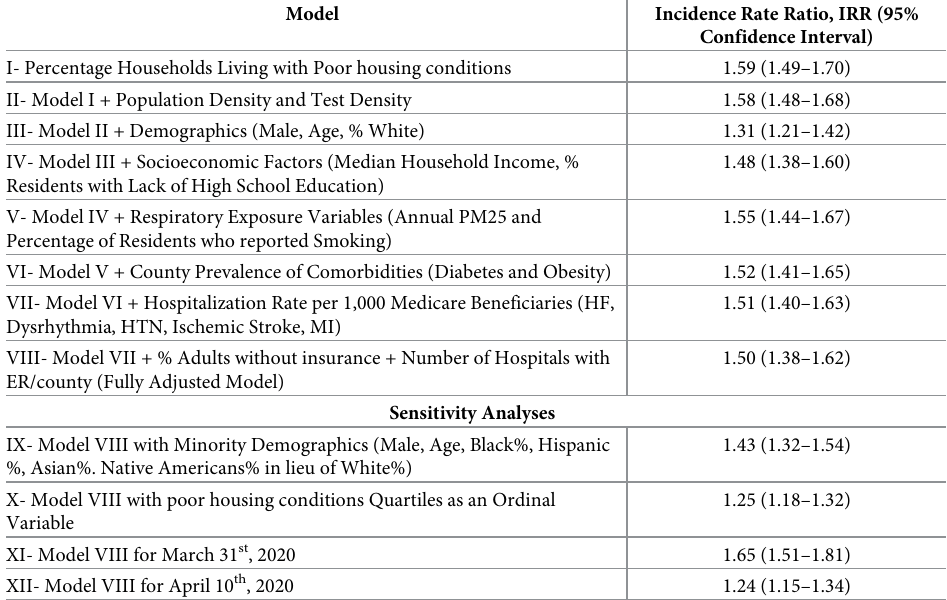
Table 2. Relative risk of county Covid-19 incidence as of April 21, 2020 related to percent households with poor housing conditions.